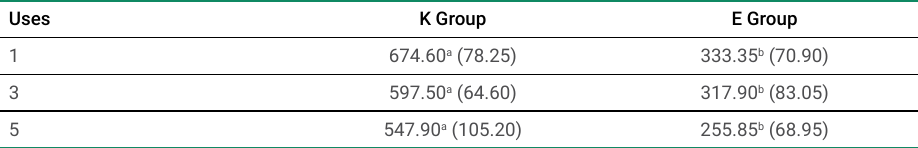
Different letters indicate the presence of statistically significant differences